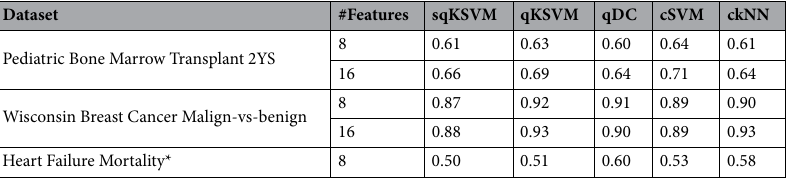
Table 3. Comparison of the cross-validation AUC performance with QML and ML algorithms. For all QML algorithms, N features are encoded into log 2 N qubits with sequences of Pauli-Y gate rotations ( R y ) and CNOT